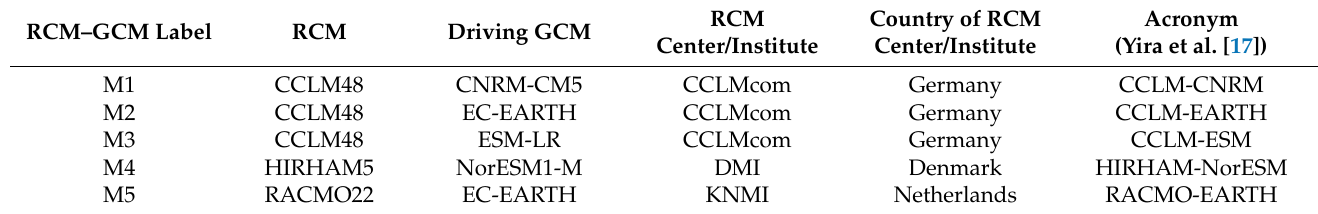
Table 1. RCM–GCM products and the research centers of their